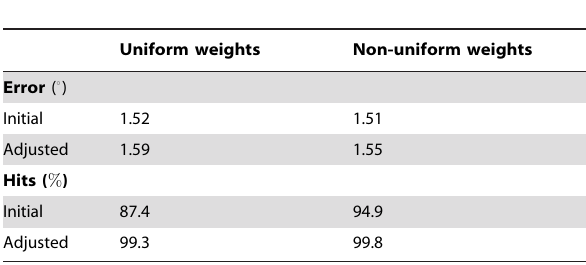
Table 3. Effect of block weighting and reference set adjustment on registration